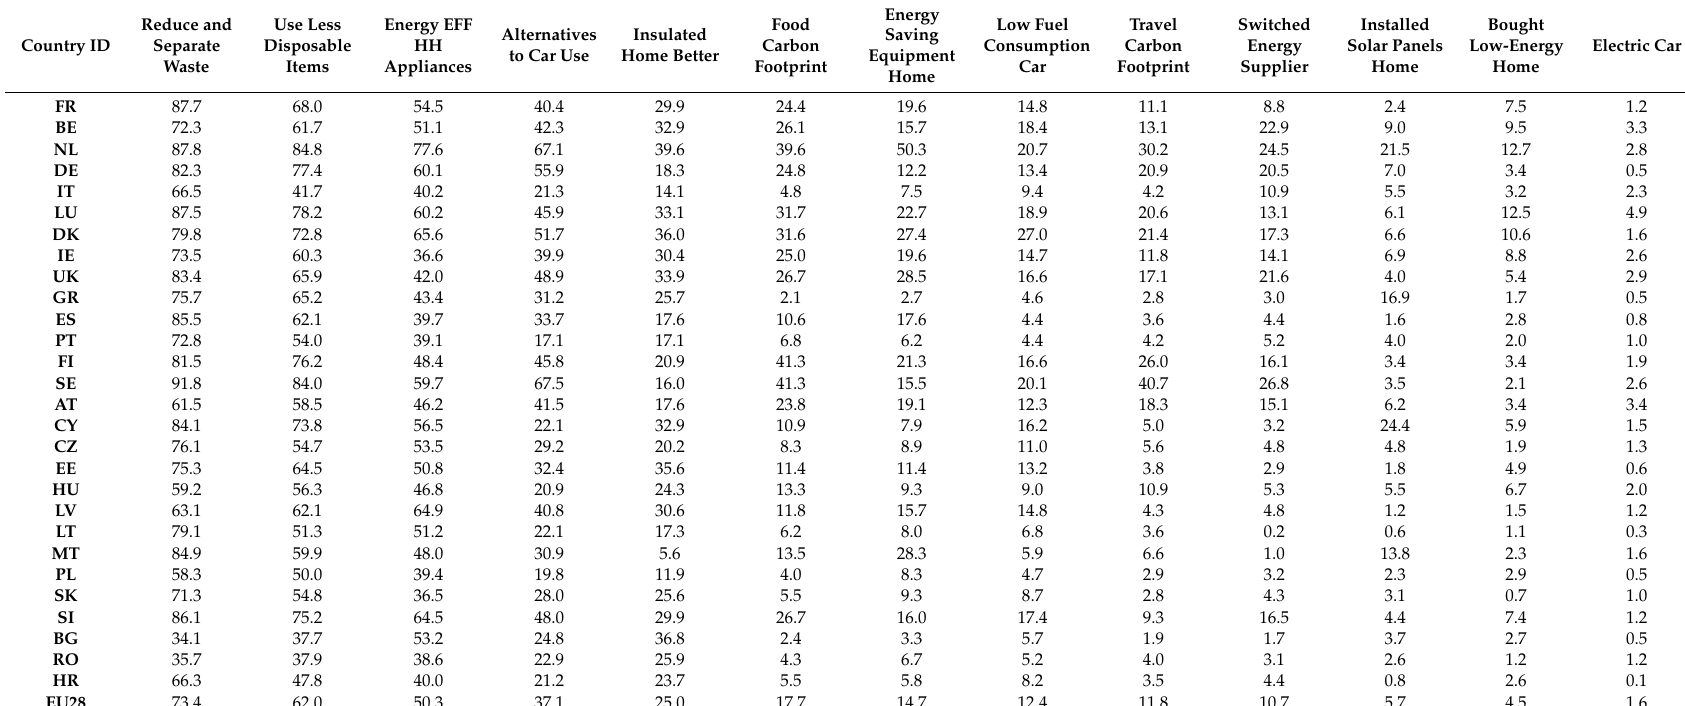
Table A2. Individuals’ climate change